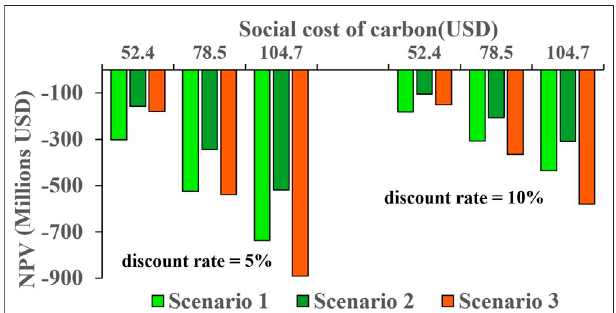
FIGURE 6 | Uncertainty analysis of the social costs of carbon emission and discount rate in the calculation of the NPV of ecosystem services in